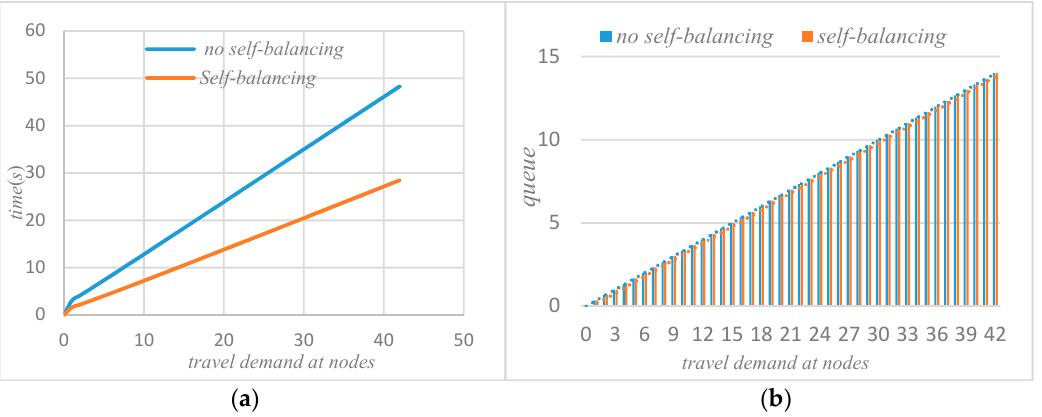
Figure 7. ( a ) Comparison of average waiting time; ( b ) Comparison of average queue.